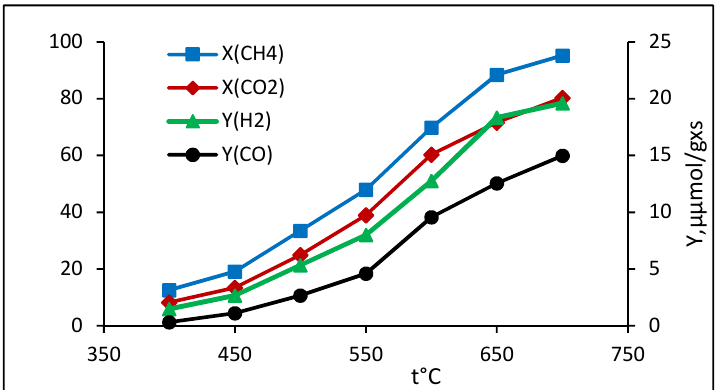
Figure 7. Effect of temperature on CO 2 -CH 4 conversion in BRM over 5%Co-Rh(98:2)/Al 2 O 3 at